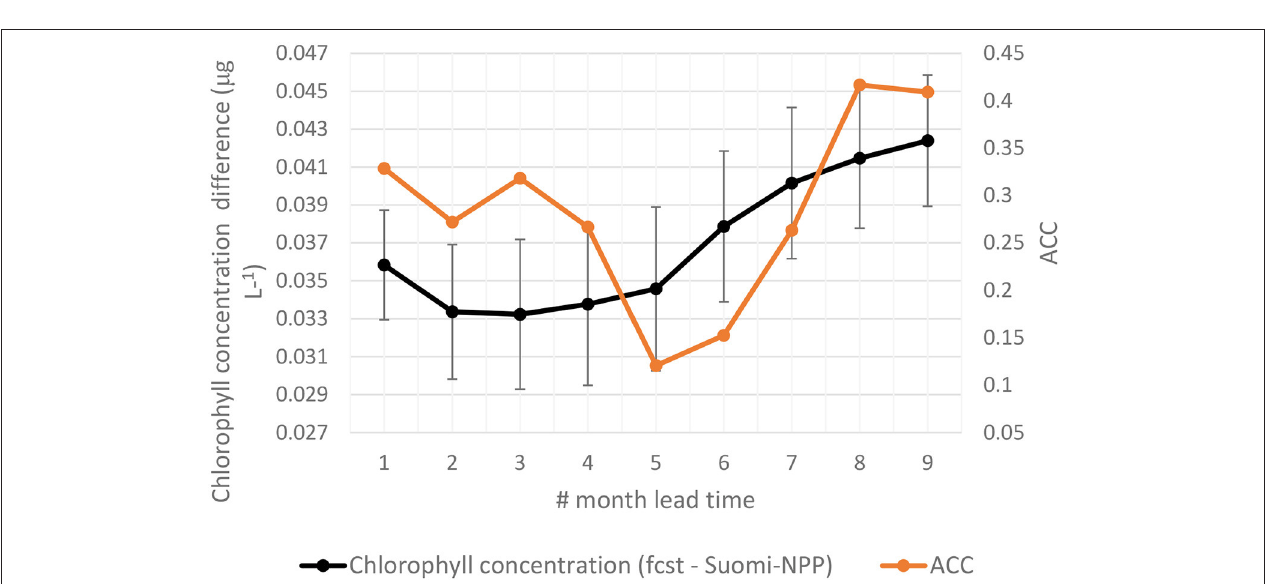
FIGURE 5 | Average difference between forecasted chlorophyll and chlorophyll from S-NPP VIIRS for corresponding month (left axis) and Anomaly Correlation Coefficient (ACC; right axis).